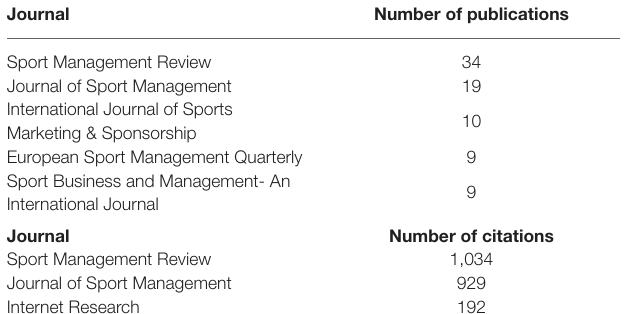
TABLE 7 | Number of publications and citations per journal.